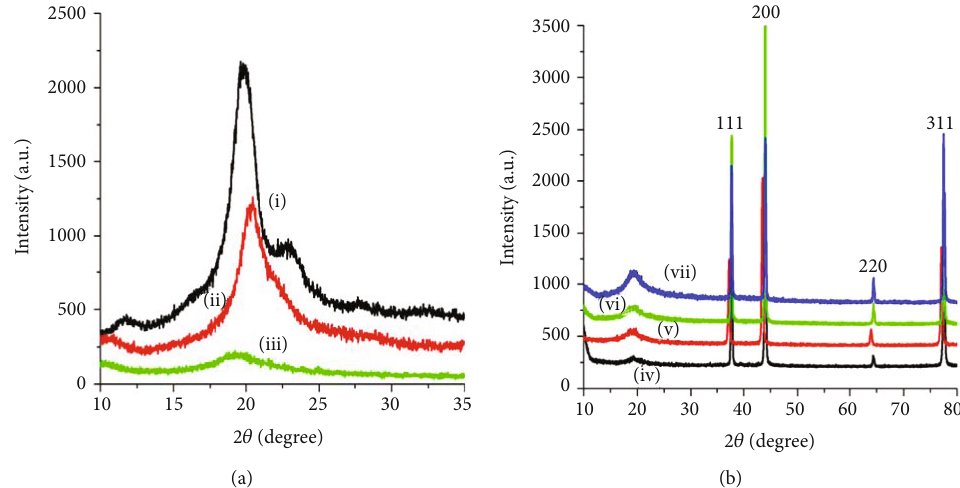
Figure 8: XRD pattern spectra of the (a) (i) pure PVA, (ii) pure CS, (iii) 30/70 CS/PVA blend, and (b) (iv) 0.1wt%, (v) 0.2wt%, (vi) 0.3wt%, and (vii) 0.4wt% Ag/Cu/CS/PVA. Voltage: 20kV; distance: